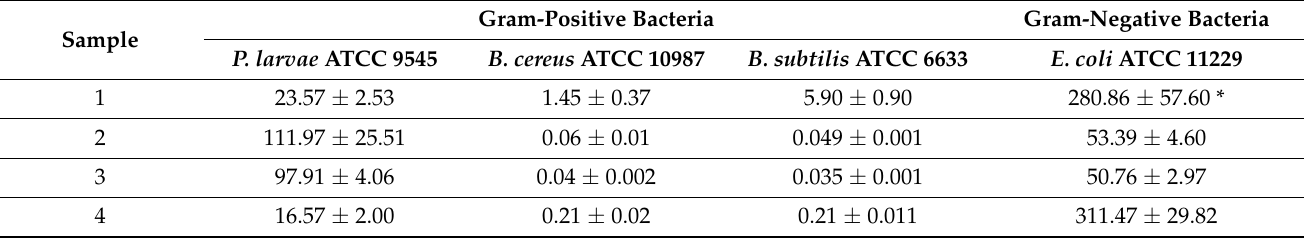
Table 6. Minimmum biofilm inhibitory concentration (MBIC 50 µ g mL − 1 ) of extracts from stingless bees (1— S. postica , 2— T. clavipes , 3— M. q. quadrifasciata , 4— T. fiebrigi